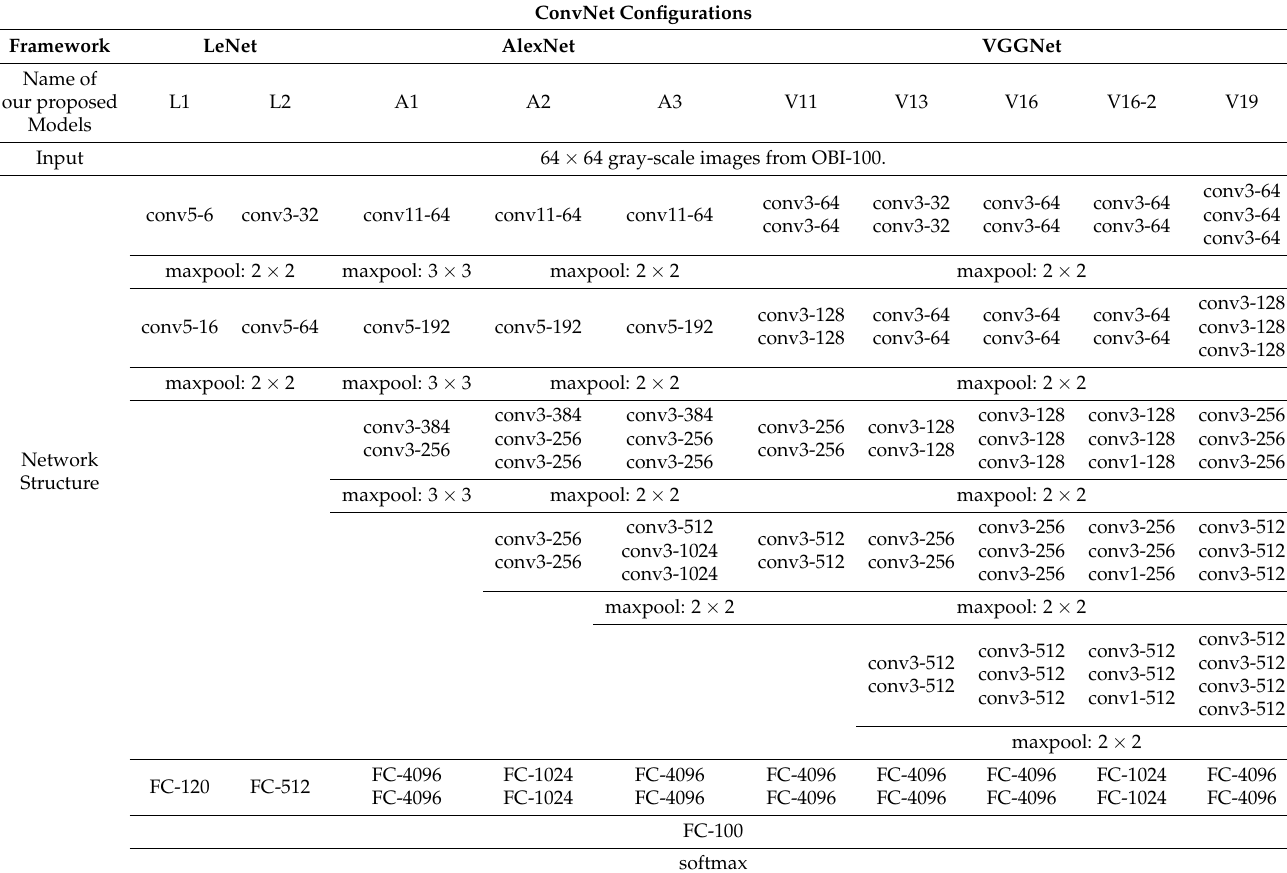
Table 1. Convolutional neural network configurations. Input: gray-scale images with a size of 64 × 64 from OBI-100. Conv x-y: a convolutional layer with a kernel size of x × x and an output dimension of the feature map of y . FC-y: a fully connected layer with an output dimension of the feature map of y ; maxpool: m × m: a max pooling layer with a kernel size of m × m . All network models use ReLU